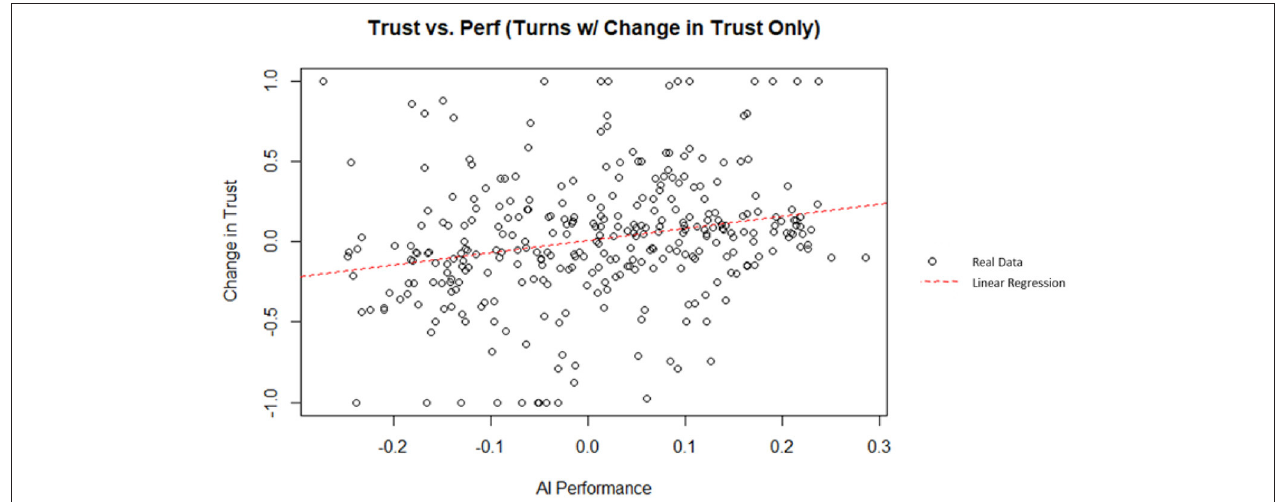
FIGURE 10 | AI performance vs. change in trust (filtered for turns with a change in trust).